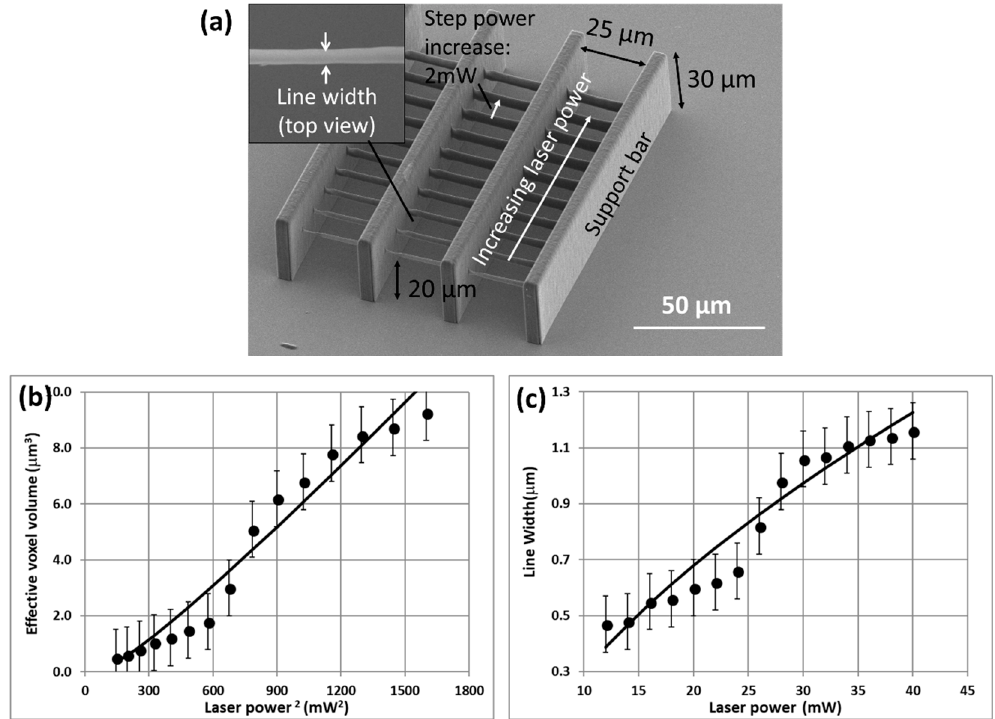
Figure 2. ( a ) Suspended line structures used to quantify 2PP line width vs. laser power for IP-S. Line widths were measured by scanning electron microscopy (SEM) (at normal incidence; see inset image) for lines printed in 2.0 mW stepped-increments of laser power; ( b ) Measured and calculated effective voxel volume vs. laser power 2 and ( c ) linewidth vs. laser power for IP-S resin. The lines were calculated using the model described in Equations (3)–(6).